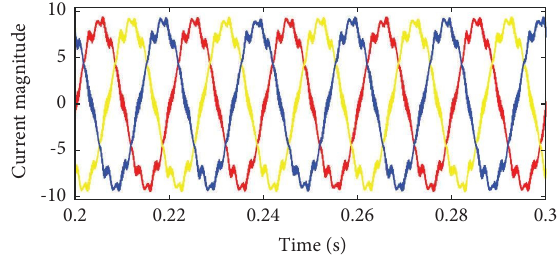
Figure 9: PSO approach output current waveforms.